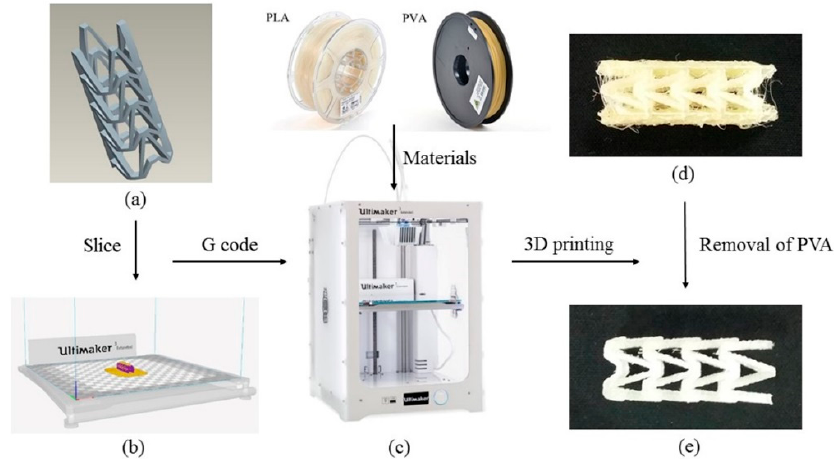
Figure 2. 3D printing process of PLA vascular stent, ( a ) The three-dimensional model of vascular stent; ( b ) The Cura software interface; ( c ) The PLA, PVA filaments and Ultimaker 3 Extended 3D printer; ( d ) The PLA vascular stent with PVA support material; ( e ) The PLA vascular stent removed PVA material.